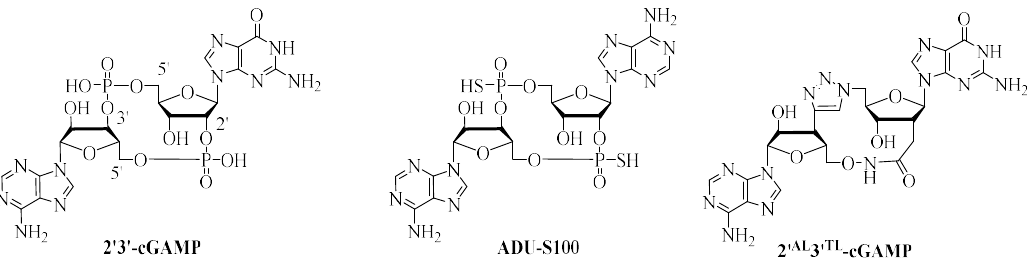
(cid:48) 3 (cid:48) -cyclic GMP-AMP (cGAMP), ADU-S100 and 2 (cid:48) AL 3 (cid:48) TL Figure 1. Structures of 2′3′-cyclic GMP-AMP (cGAMP), ADU-S100 and 2′ AL 3′ TL -cGAMP. Figure 1. Structures of 2